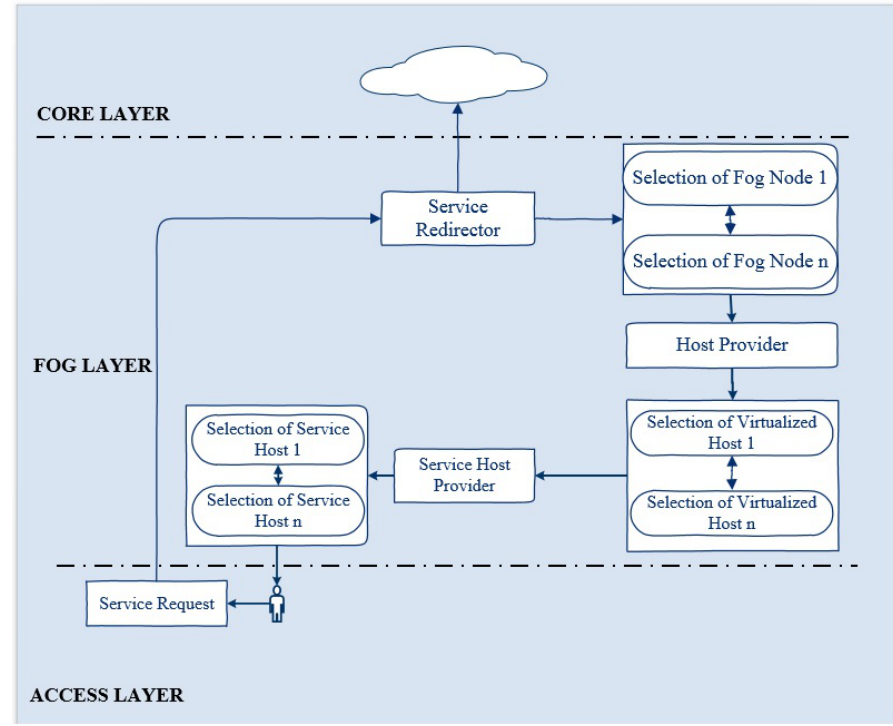
Figure 2. Workflow of the proposed